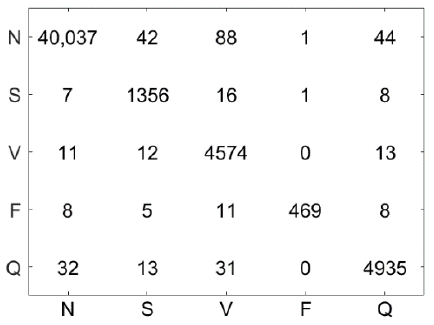
Figure 17. Confusion matrix using the DCSC + LSVM model.